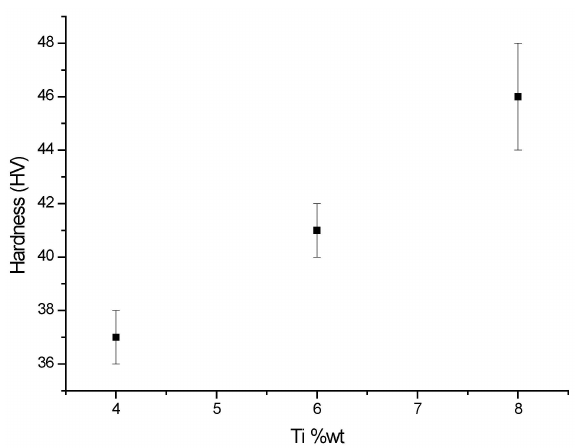
Figure 4. Hardness values of A356 different amounts of Ti added.